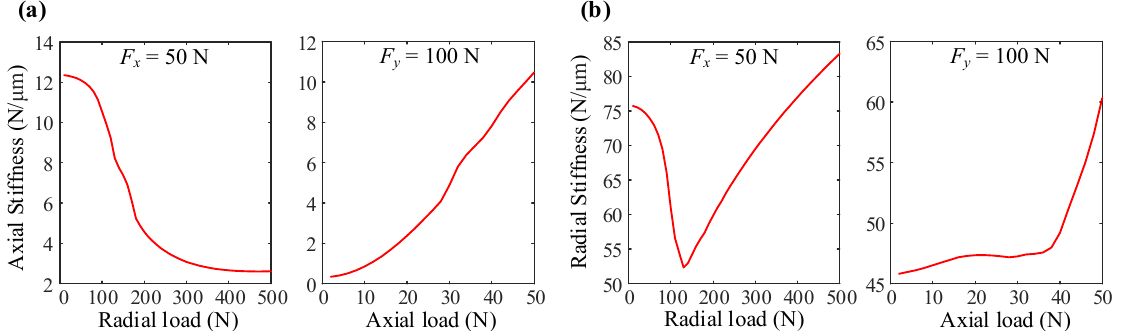
Figure 10. The stiffness variation for ball bearing acted by small axial load and large radial load: ( a ) The axial stiffness varies against radial or axial load; ( b ) The radial stiffness varies against radial or axial load.